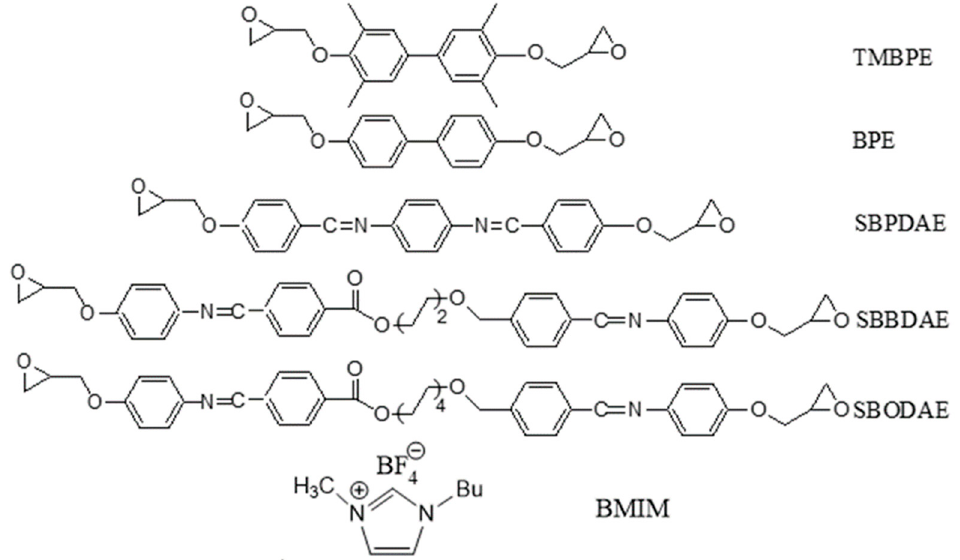
Figure 2. The chemical structures of TMBPE, BPE, SBPDAE, SBBDAE, SBODAE, and BMIM.